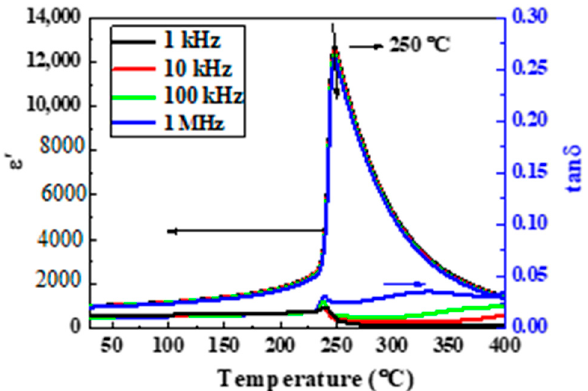
Figure 2. The dependence of the dielectric constant ( ε ′ ) and dielectric loss (tan δ ) on the temperature [110] crystals at di ff erent frequencies (1 kHz to 1 of [110] crystals at different frequencies (1 kHz to 1 MHz).